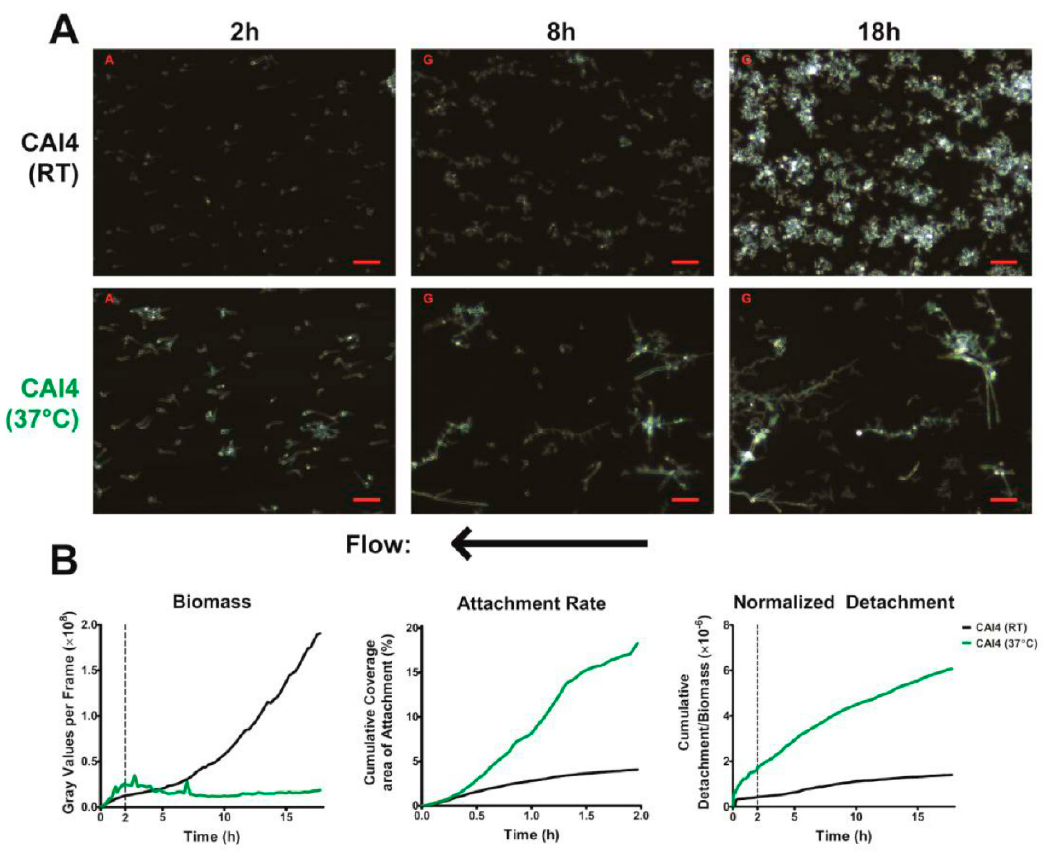
Figure 2. Biofilm Formation under Flow: ( A ) Representative darkfield images of biofilm formation under flow are shown for wild-type cells at room temperature (top, black) and 37 °C (middle, green) at 2, 8 and 18 h of growth. Scale bars indicate 50 µm. Arrow indicates direction of media flow for every image; ( B ) The total biomass within the imaging region (determined by densitometry analysis), the rate of cell attachment, and the detachment rate normalized to the biomass over time are shown. Data are means of n ≥ 3 experiments.